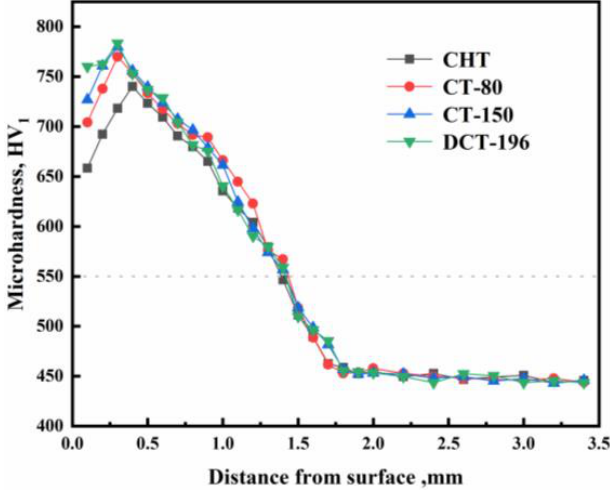
Figure 7. Microhardness of 17Cr2Ni2MoVNb alloys steel under different heat treatments.